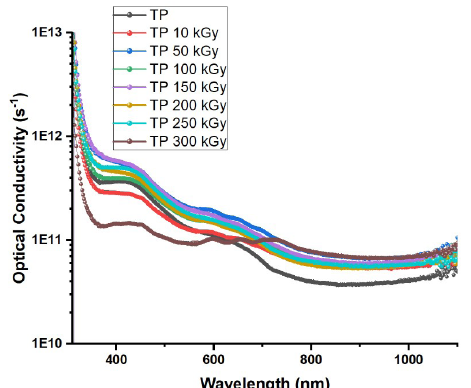
Figure 7. Optical conductivity of different gamma-absorbed doses of TIPS